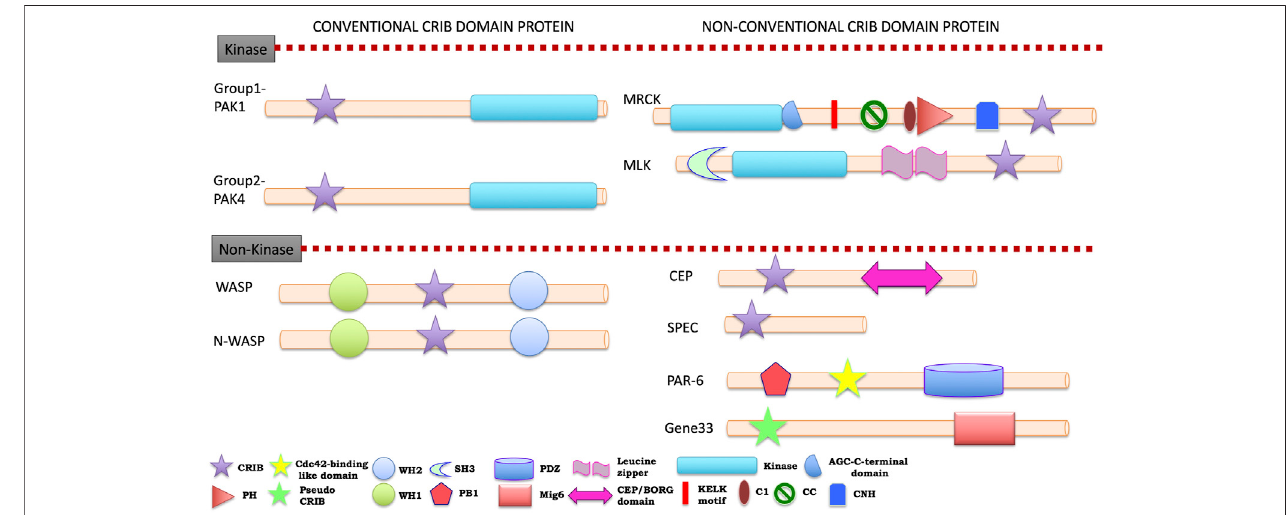
FIGURE5| CartoondiagramofsignaturedomainorganizationofhumanCRIBdomaincontainingproteinfamiliesAcolourkeytothedomainnamesandsymbolsis given below of classi fi cation. The abbreviations for the domains are: CRIB, Cdc42/Rac interactive binding; PH, pleckstrin-homology; WH1, Enabled/VASP homology 1; WH2, WASP homology 2; SH3, Src-homology 3 doamin; PB1, Phox and Bem1; PDZ, PSD-95, Drosophila discs large, and the adherens junction protein, ZO 1; CEP, CRIBeffectorprotein;CNH,Citronhomologydomain.Theproteinsdividedintoconventionalandunconventionalclassi fi cationonthebasisoftheirevolutionarylink with unicellular